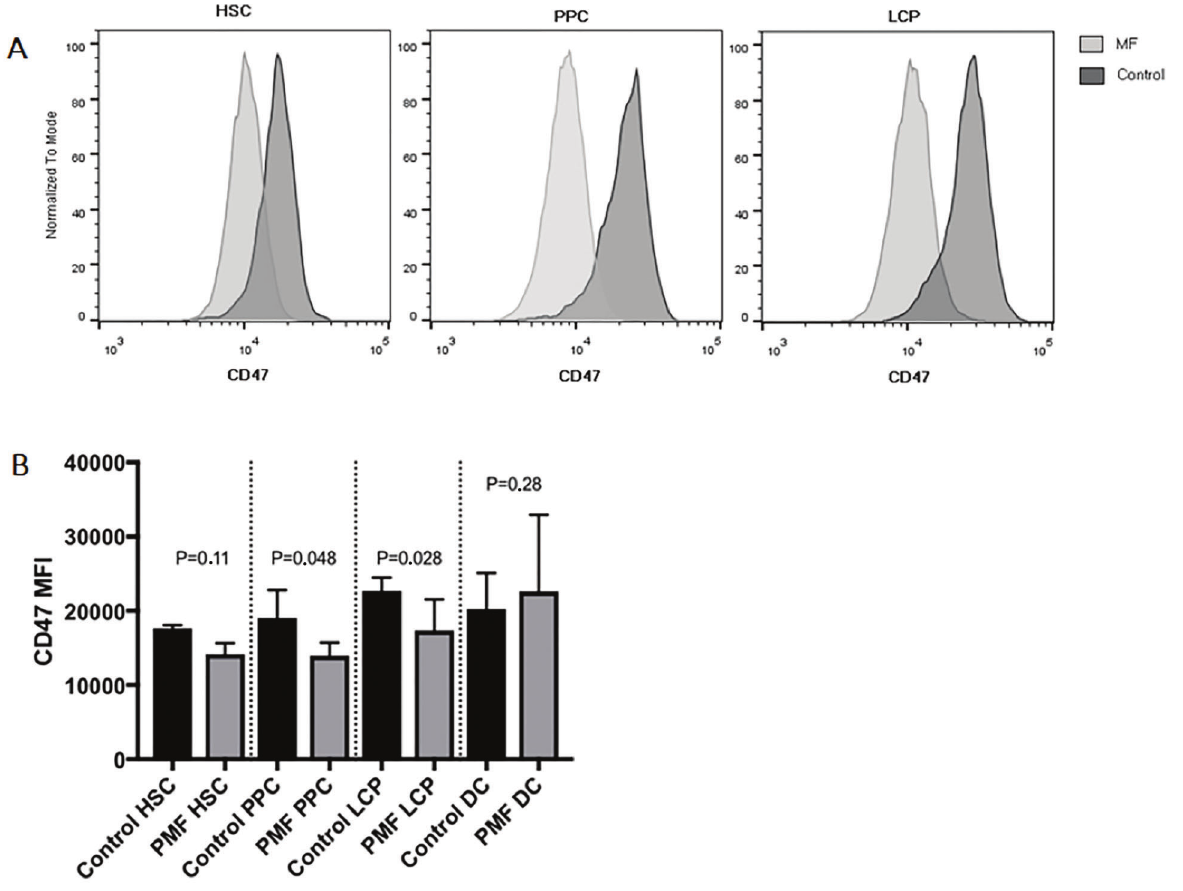
Figure 3. CD47 expression in different cell compartments of control vs myelo fi brosis (MF) cells. A , Histograms of representative experiments; B , Comparison of average mean fl uorescence intensity (MFI) (Welch-corrected Student ’ s t -test). Data are reported as mean ± SD. HSC: hematopoietic stem cells; PPC: pluripotential progenitor cells; LCP: lineage committed progenitors; DC: differentiated cells.